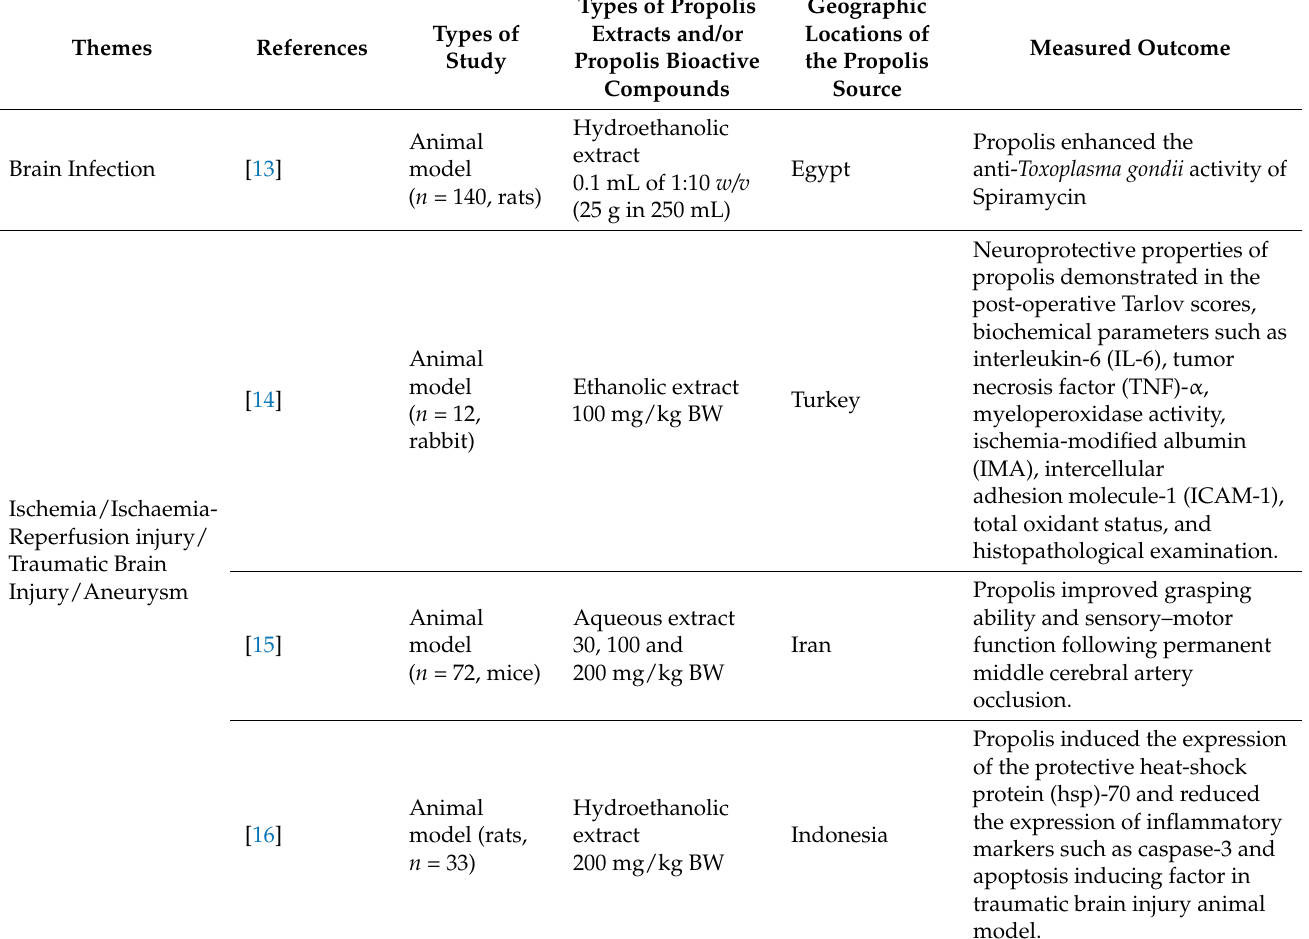
Table 2. The summary of the included studies in the present scoping